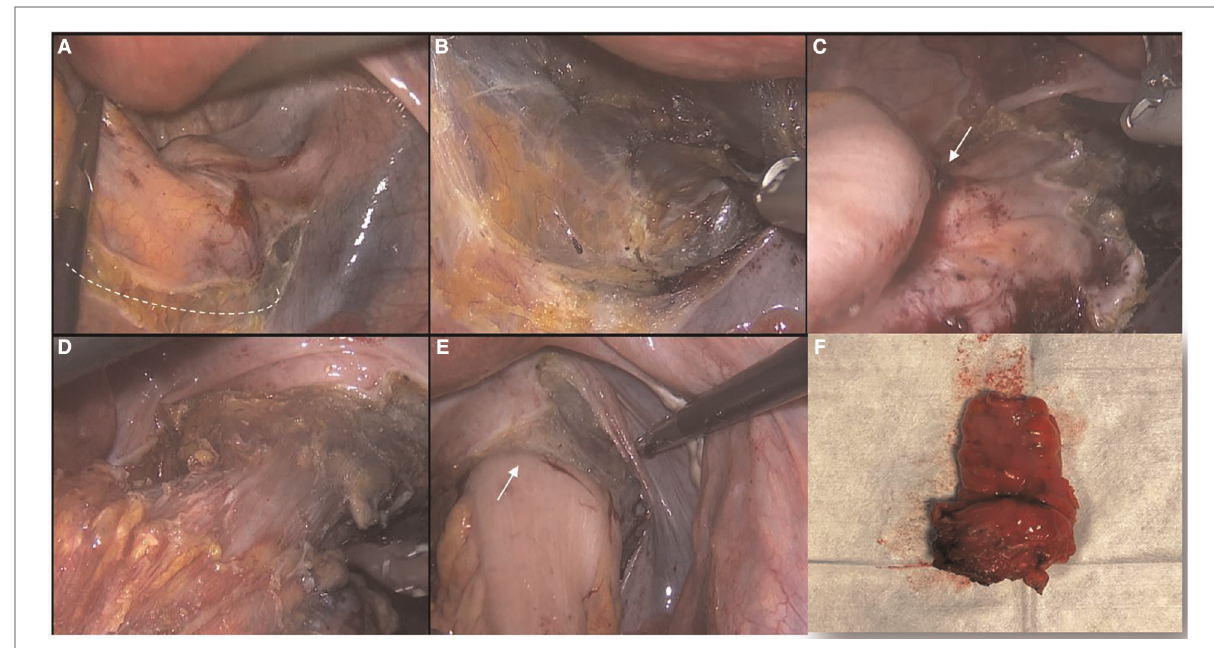
FIGURE 3 Surgical steps of laparoscopic segmental colorectal resection for endometriosis; ( A ) posterior approach to the mesorectum: the dashed line indicates the correct dissection plane; ( B ) sharp dissection of mesorectum in order to preserve the hypogastric nerves and vascular structures; ( C ) anterior dissection along Denonvilliers fascia below the endometriosis lesion; ( D ) complete surgical preparation of the rectum; ( E ) end-to-end anastomosis; ( F ) resected